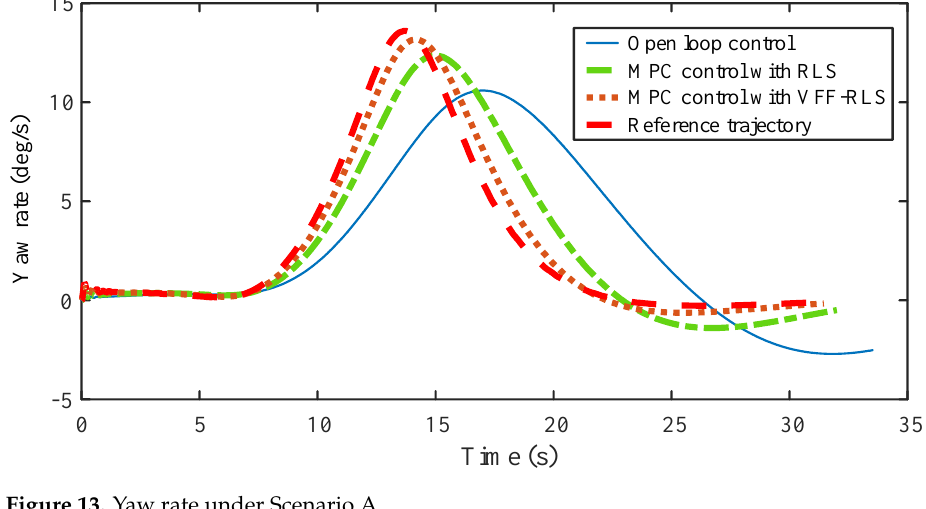
Figure 12. Lateral deviation under Scenario A.